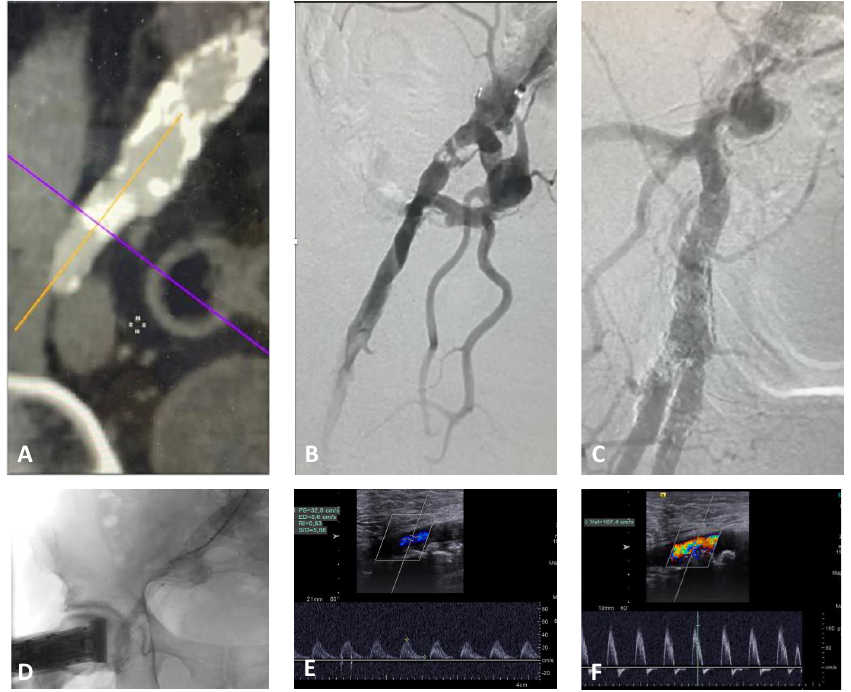
Figure 3. Case 1, right iliac external subocclusion, treated by intravascular lithotripsy without stenting from brachial access. ( A ) Preoperatory CT scan; ( B ) initial angiogram; ( C ) completion angiogram; ( D ) EVUS with preoperative ( E ) and postoperative ( F ) waveforms, changing from monophasic to biphasic